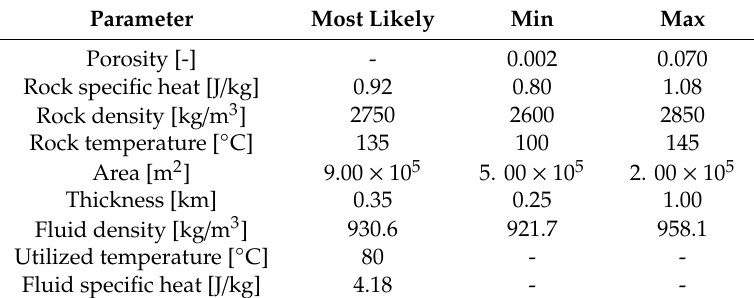
Figure 7. Field view of Balcova geothermal field [24]. Table 2. Properties of Balcova geothermal reservoir [25].